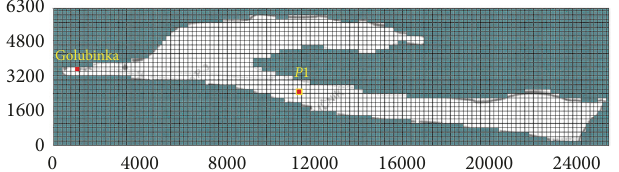
Figure 10: The Modflow domain of the Golubinka basin and the location of Golubinka spring and piezometer 𝑃1